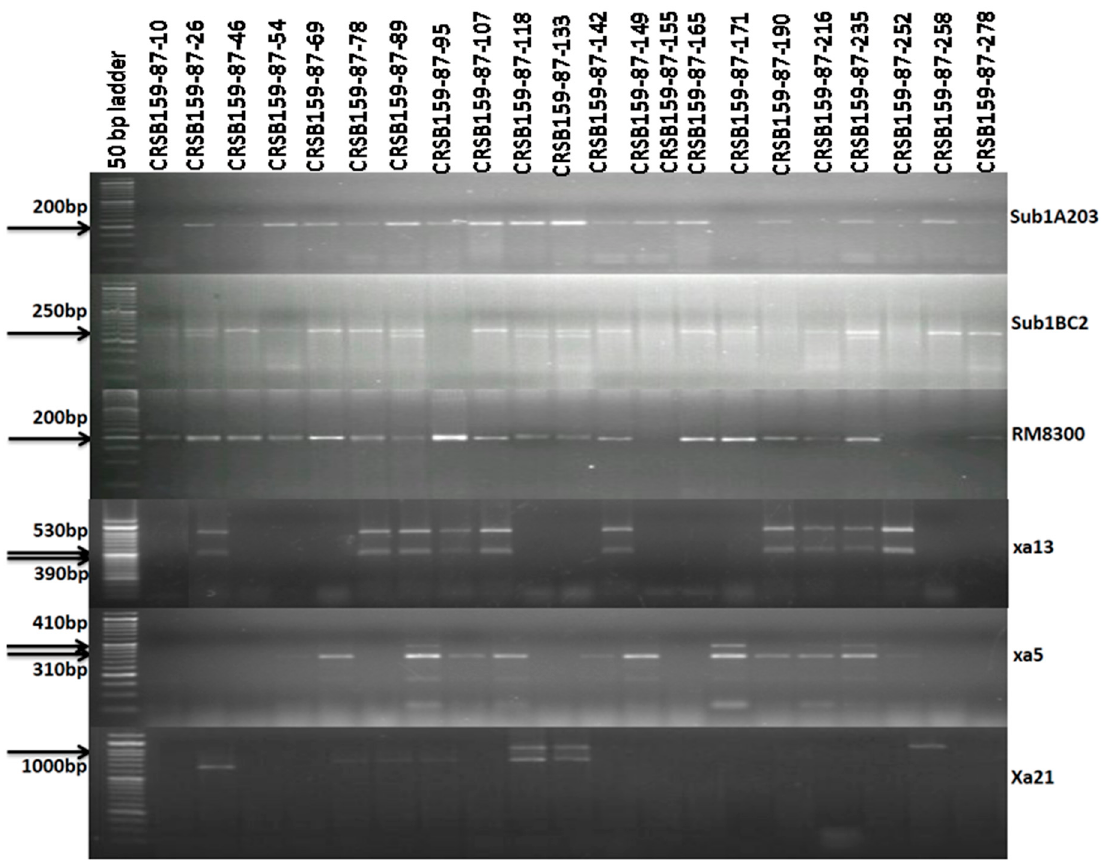
Figure 5. Representative electropherogram of BC 3 F 1 -derived lines of Ranidhan using submergence tolerance markers (Sub1BC2 and Sub1A203) and markers for bacterial blight resistance genes Xa21 , xa13 , and xa5 . The numbers at the top indicate the BC 1 F 1 generation of Ranidhan-derived lines. A 50 bp DNA ladder was used.